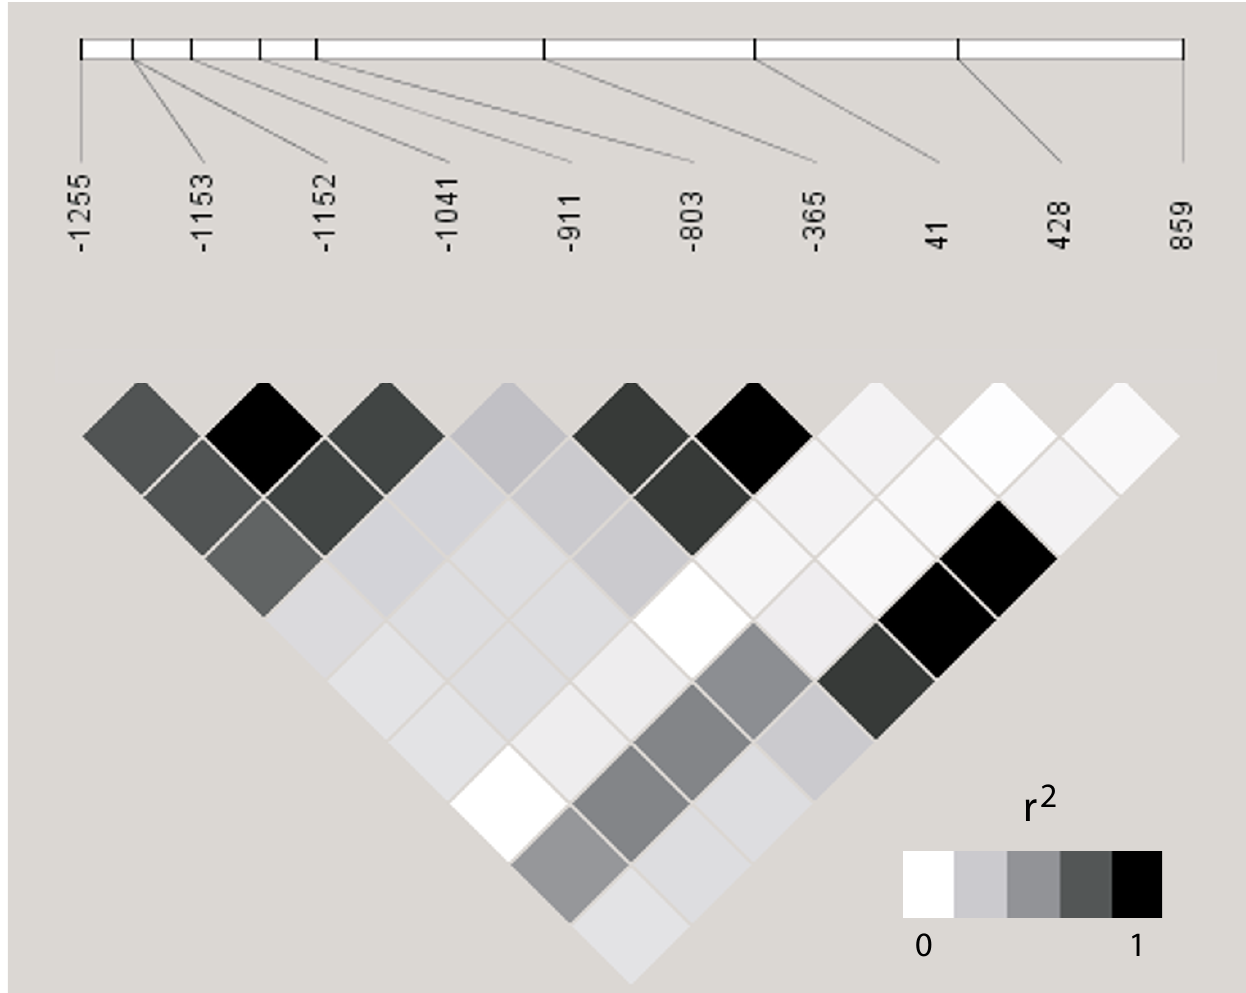
Figure 3 LD structure of the resequenced NAT8 genomic region shown as r 2 -blot. Upper white bar depicts the positions of identified SNPs (Table 2) relative to the location of NAT8 gene ATG (A denoted as +1). Singleton polymorphisms were excluded from